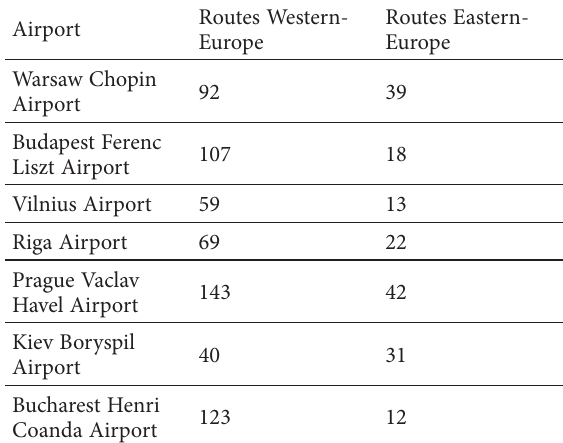
Table 1. List of routes to Eastern-Europe and Western-Europe Airport